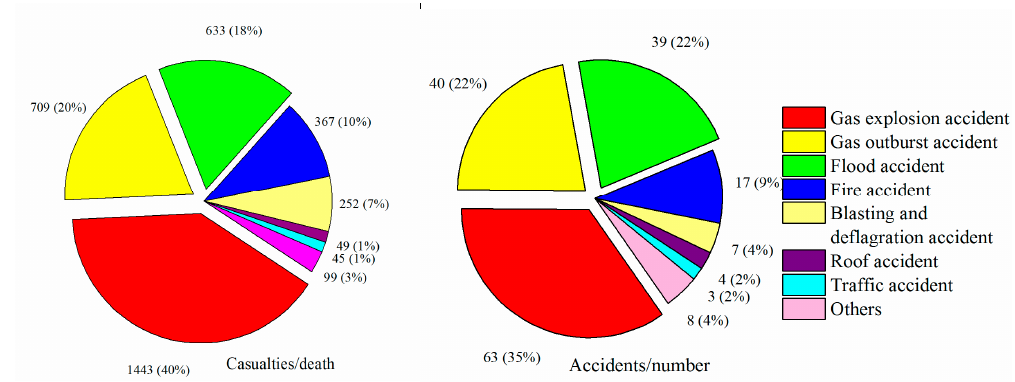
Figure 1. Classification statistics of major accidents in China during 2007–2016. Data from the accident reports released by the National Coal Mine Safety Administration from 2007 to 2016 [2–11].